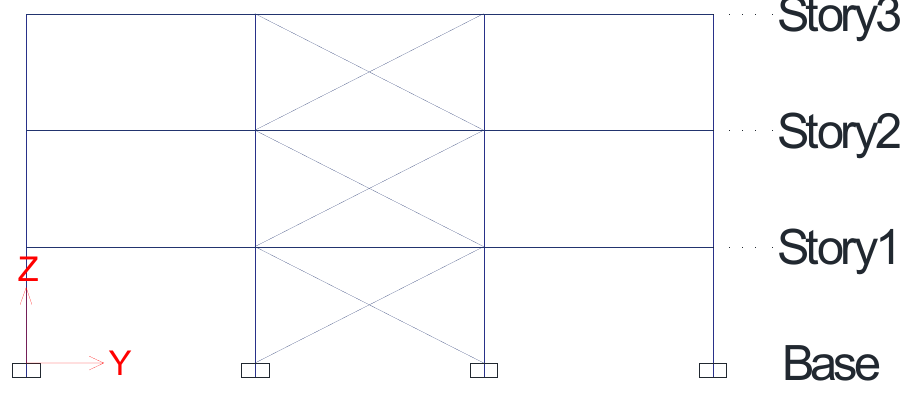
Figure 4. 3 Story building frame in the Etabs